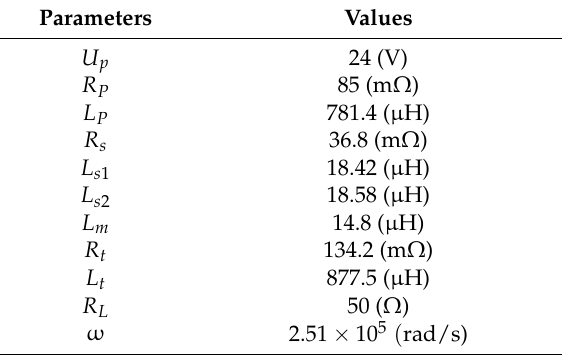
Table 2. Prototype’s original parameters.